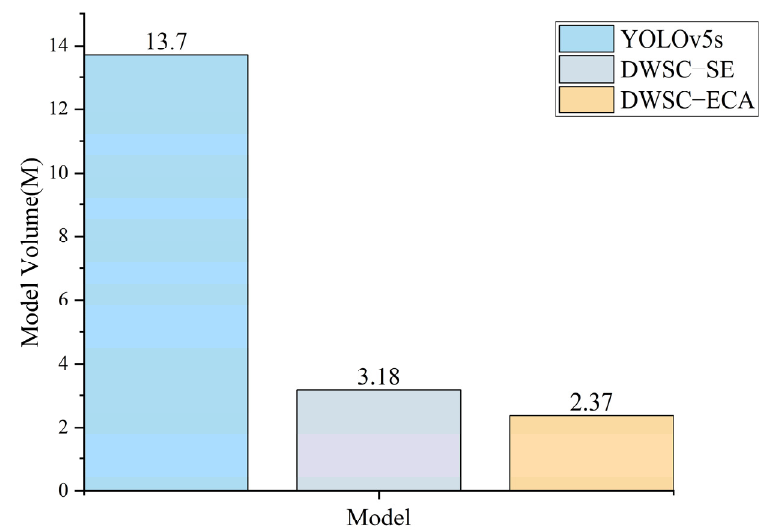
Figure 5. Model Volume comparison.